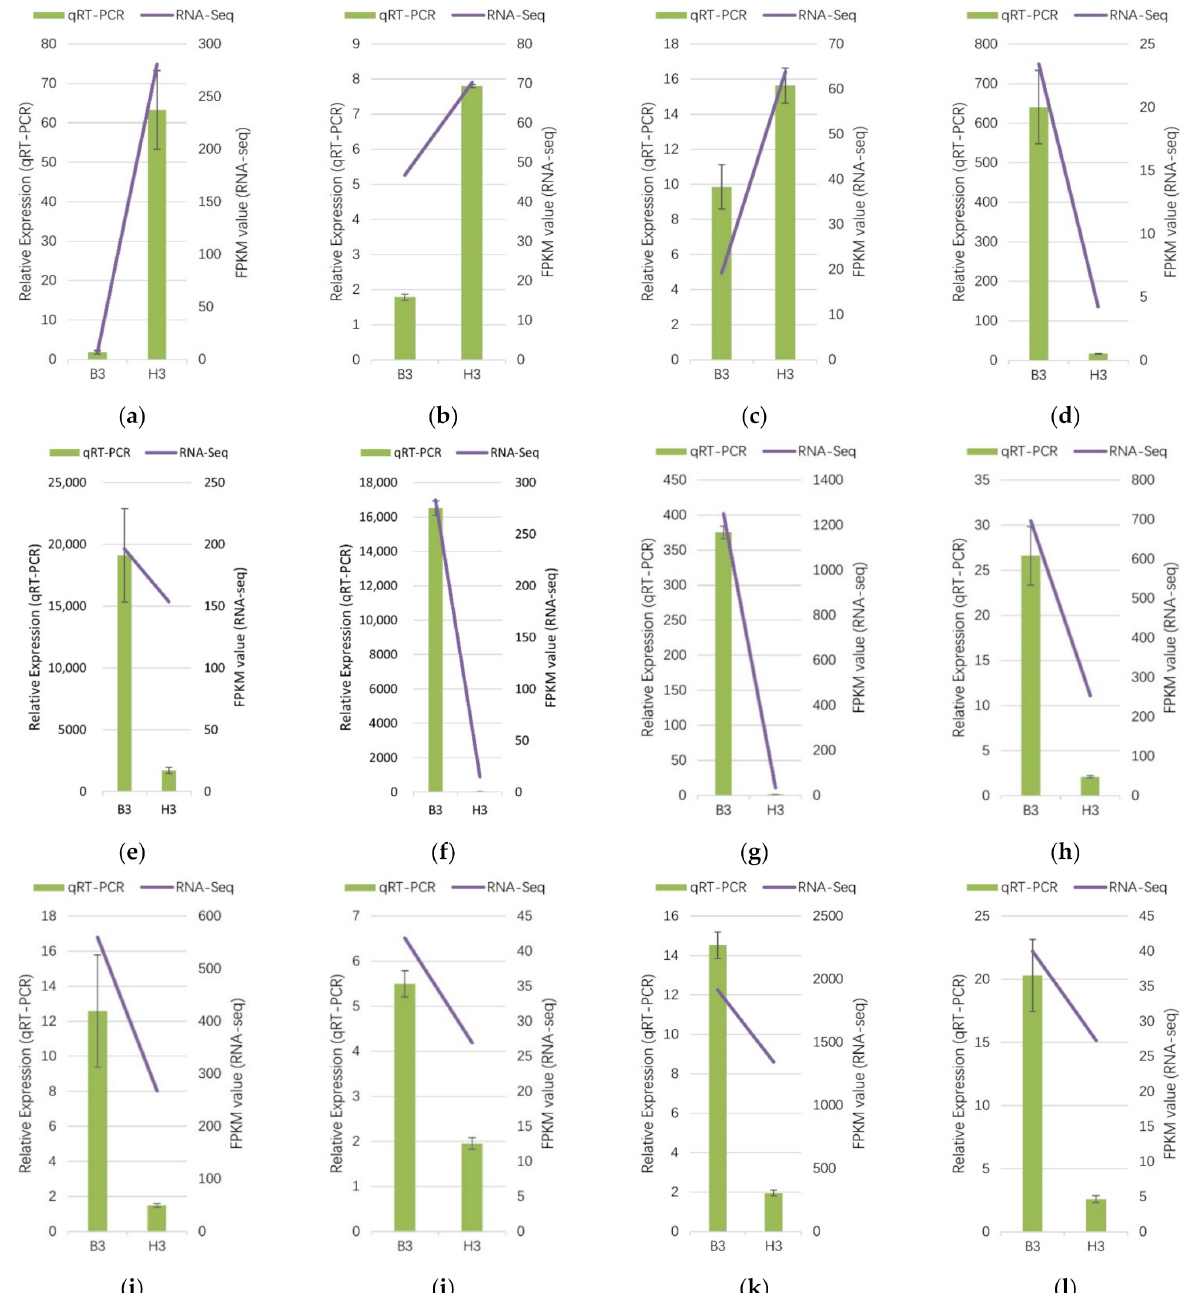
Figure 9. Verification of RNA-Seq data of carotenoid biosynthesis related DEGs by qRT- PCR. ( a ) c149089.graph_c0 ( PSY 1); ( b ) c150178.graph_c0 ( PSY 2); ( c ) c147078.graph_c0 ( CCS );